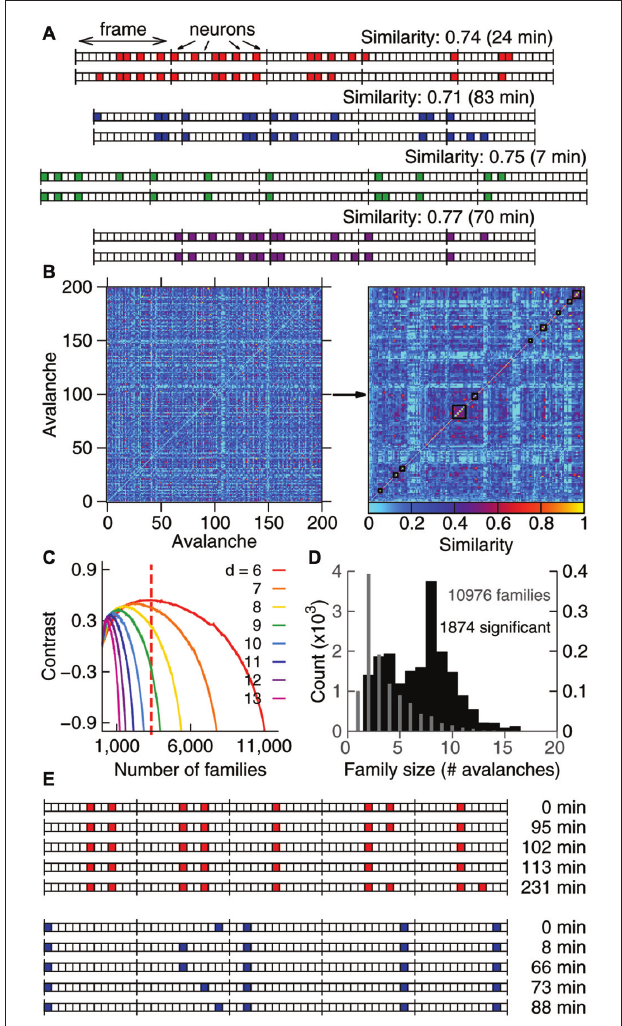
FIGURE 1 | Avalanches in freely-behaving animals comprise families and recur above chance. (A) Avalanches represented as binary vectors in which colors indicate spike activity. Depicted are representative examples from four different samples of similar avalanche pairs separated by several minutes (interval of recurrence indicated on the right). (B) Similarity matrix for 200 representative avalanches from one sample, before and after clustering (left and right panels, respectively). Black lines indicate 10 families formed by similar avalanches. (C) Contrast function for one sample (colors represent different avalanche durations), with the maximum for one duration indicated by the dashed line. (D) Number of families of each size for one sample. Gray indicates all families detected (left Y axis); black indicates significant families (right Y axis). Note that the Y axes are scaled by a factor of 1000. (E) The recurrence over time of highly similar avalanches defines avalanche families. For the two representative families shown, the occurrence time is relative to the first observed